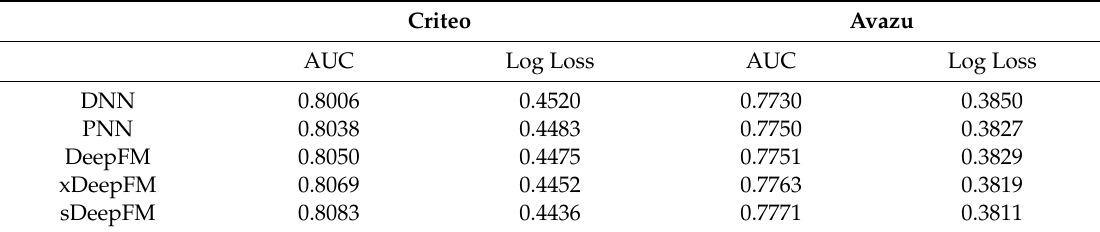
Table 3. Comparison of MSSP with other models without a DNN module. PNN—product-based neural network. Criteo Avazu